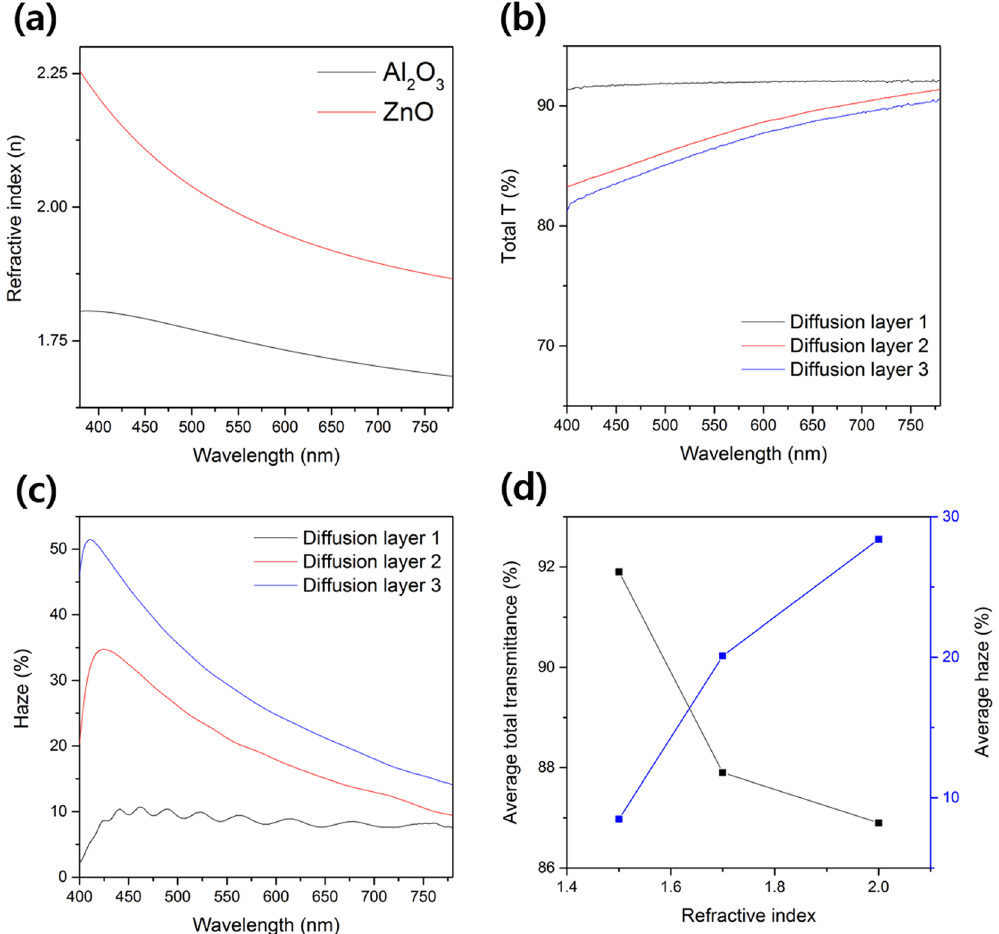
Figure 2. ( a ) Refractive indices of Al 2 O 3 and ZnO, ( b ) total transmittance of diffusion layers, ( c) haze of diffusion layers, and ( d ) average total transmittance and haze according to refractive index of diffusion